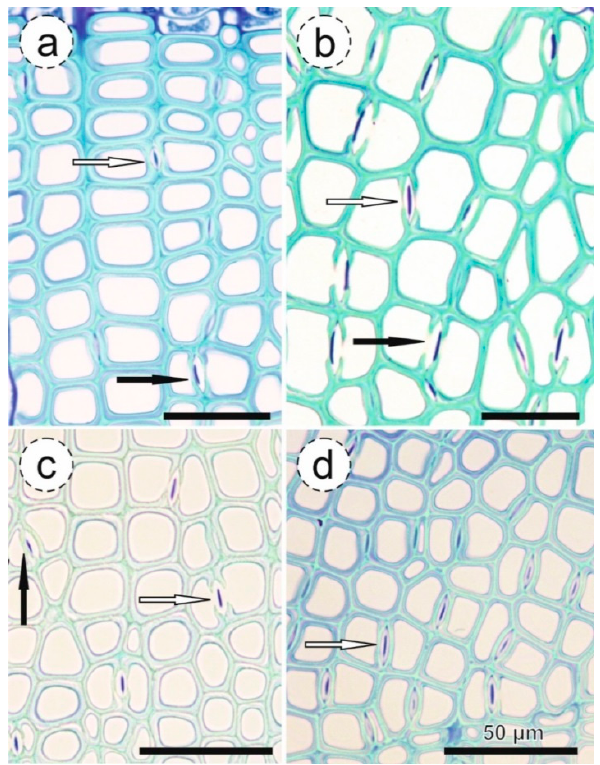
Figure 2. Examples of open and aspirated bordered pits in sapwood of Pinus mugo . ( a ) 24 November 2010, ( b ) 22 February 2011, ( c ) 15 June 2011, and ( d ) 6 July 2011, open arrows point at open bordered pits, closed arrows on aspirated bordered pits, reference bars = 50 µm.